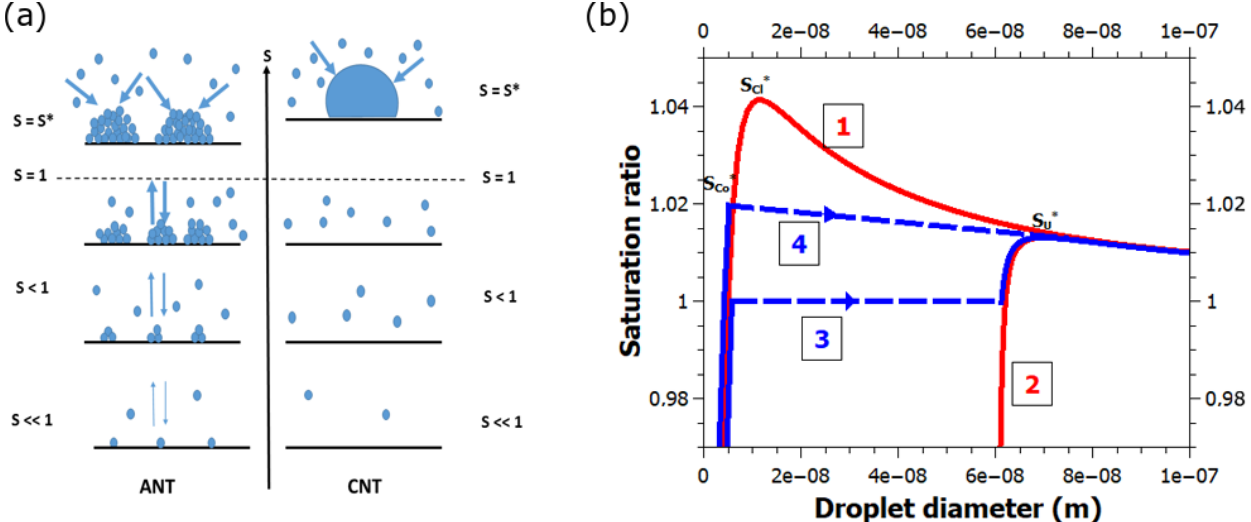
Figure 1. (a) A schematic showing the principal differences between ANT and CNT. ANT is based on the premise that vapor molecules are already adsorbed on the surface at subsaturation, and the molecular nature of adsorption is reflected in the values of the FHH parameters A and B that are obtained from experimental adsorption equilibria. The premise of CNT is that liquid droplets appear on the surface once the vapor becomes supersaturated. When experimental contact angles are used, CNT predicts higher critical supersaturations S ∗ (at which unlimited condensation starts) than ANT. In practice, the contact angle used for CNT is an adjustable parameter to fit experiments, whereas for ANT it is the bulk (observed) value, adjusted owing to the interaction of adsorbed water molecules on the surface. (b) Schematic Köhler- type curves for various heterogeneous nucleation pathways of water on a 60nm spherical particle. Curve 1 depicts the saturation ratio as a function of the diameter of individual droplets with a contact angle of 30 ◦ . Nucleation takes place at the maximum of the curve. Curve 2 is the Köhler curve for the FHH activation mechanism, corresponding to a contact angle of 0 ◦ . Curve 3 corresponds to a situation where the droplets fill the surface of the solid particle just below S = 1 and coalesce to form a uniform liquid film, which then grows along curve 2 until nucleation occurs at the maximum. Curve 4 is similar to curve 3, but the droplets fill the surface at S = 1 . 02 and nucleation occurs instantaneously because the saturation ratio is higher than the maximum of curve 2. Note that the blue curves have been slightly offset along the x axis for